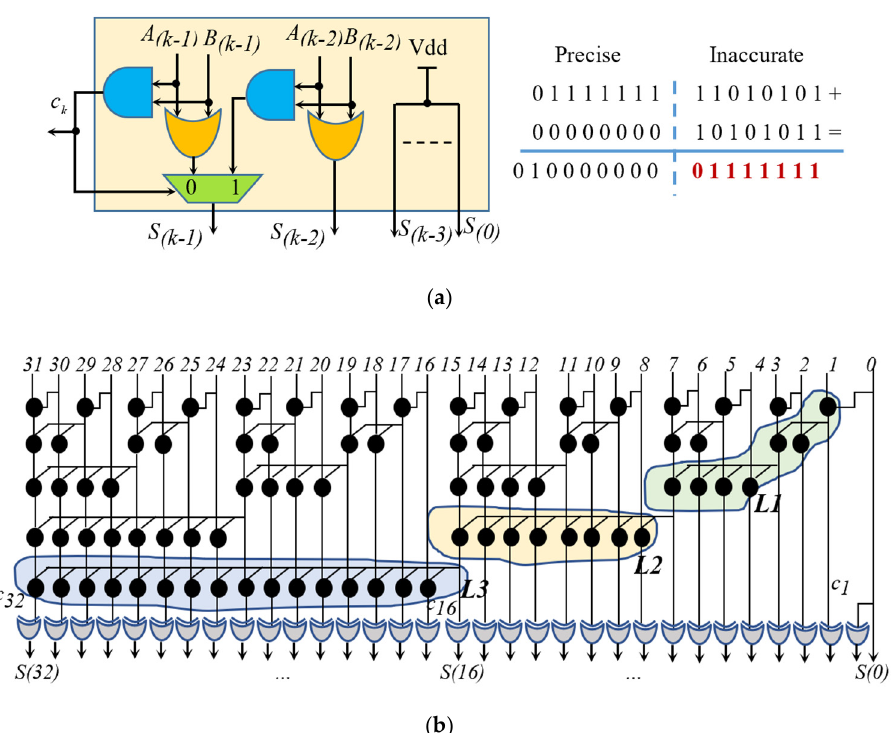
Figure 2. Existing approximate adders: ( a ) Hardware Optimized and Error Reduced Approximate Adder (HOERAA) [17]; ( b ) Sklansky [18].